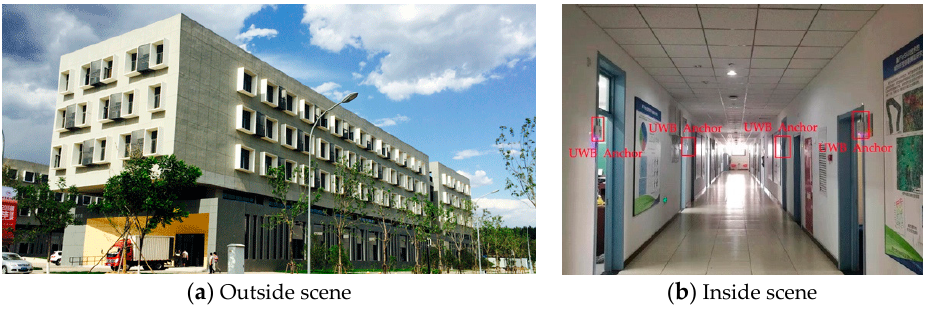
Figure 5. Pedestrian indoor positioning experiment scene.